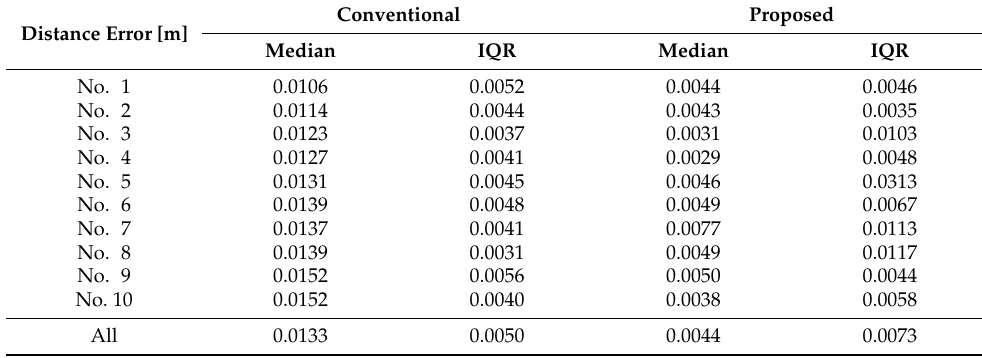
Table 4. Median and interquartile range (IQR) of the distance error—square pattern. Conventional Distance Error [m]